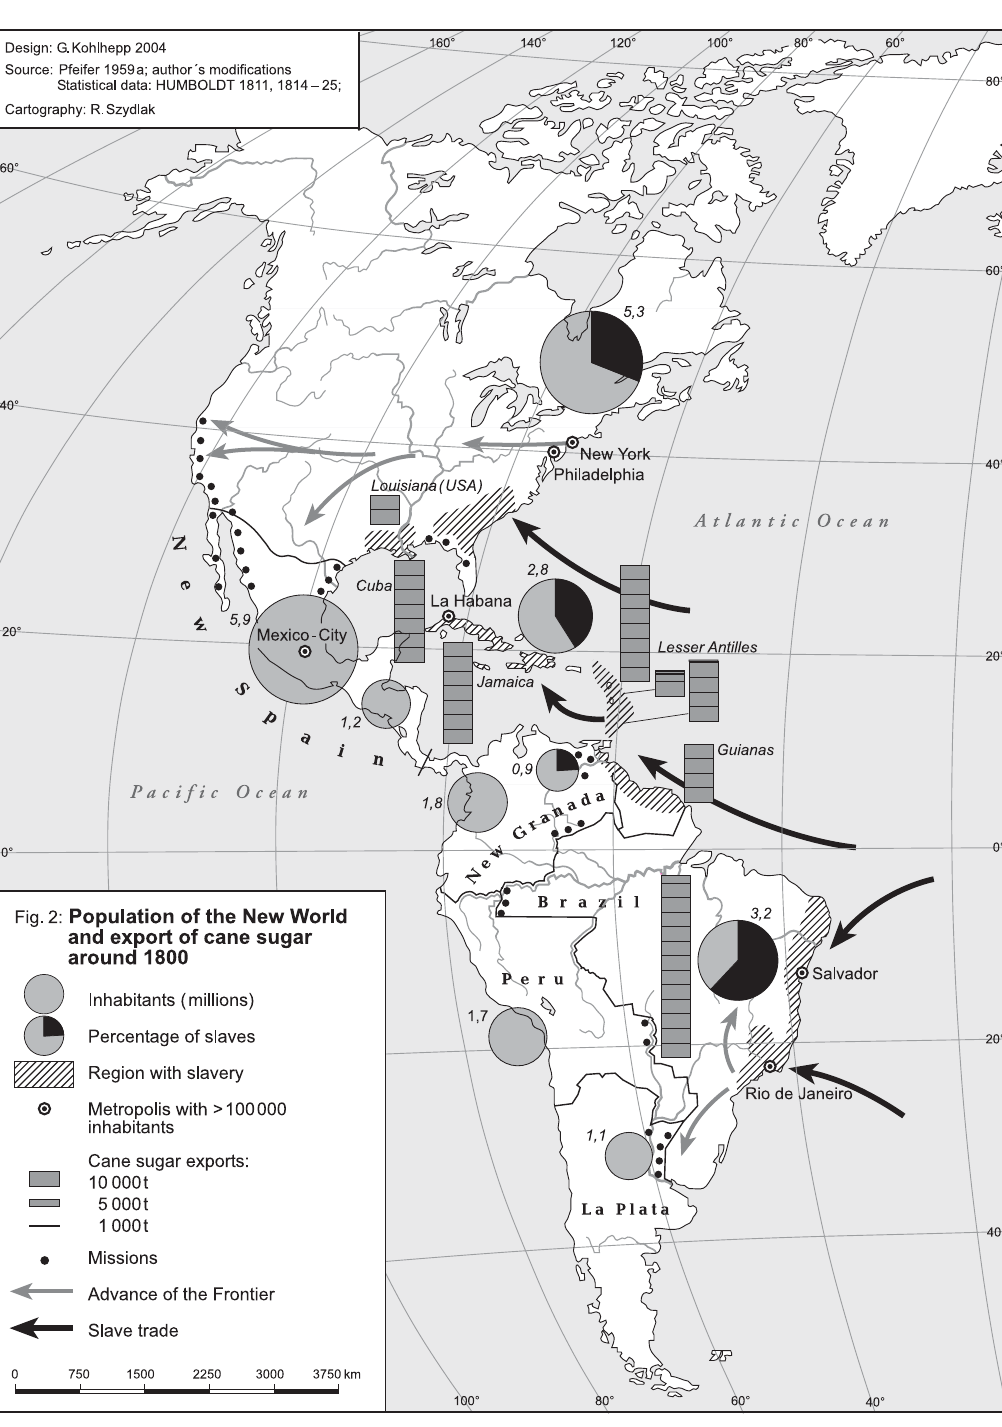
An Acad Bras Cienc (2005) 77